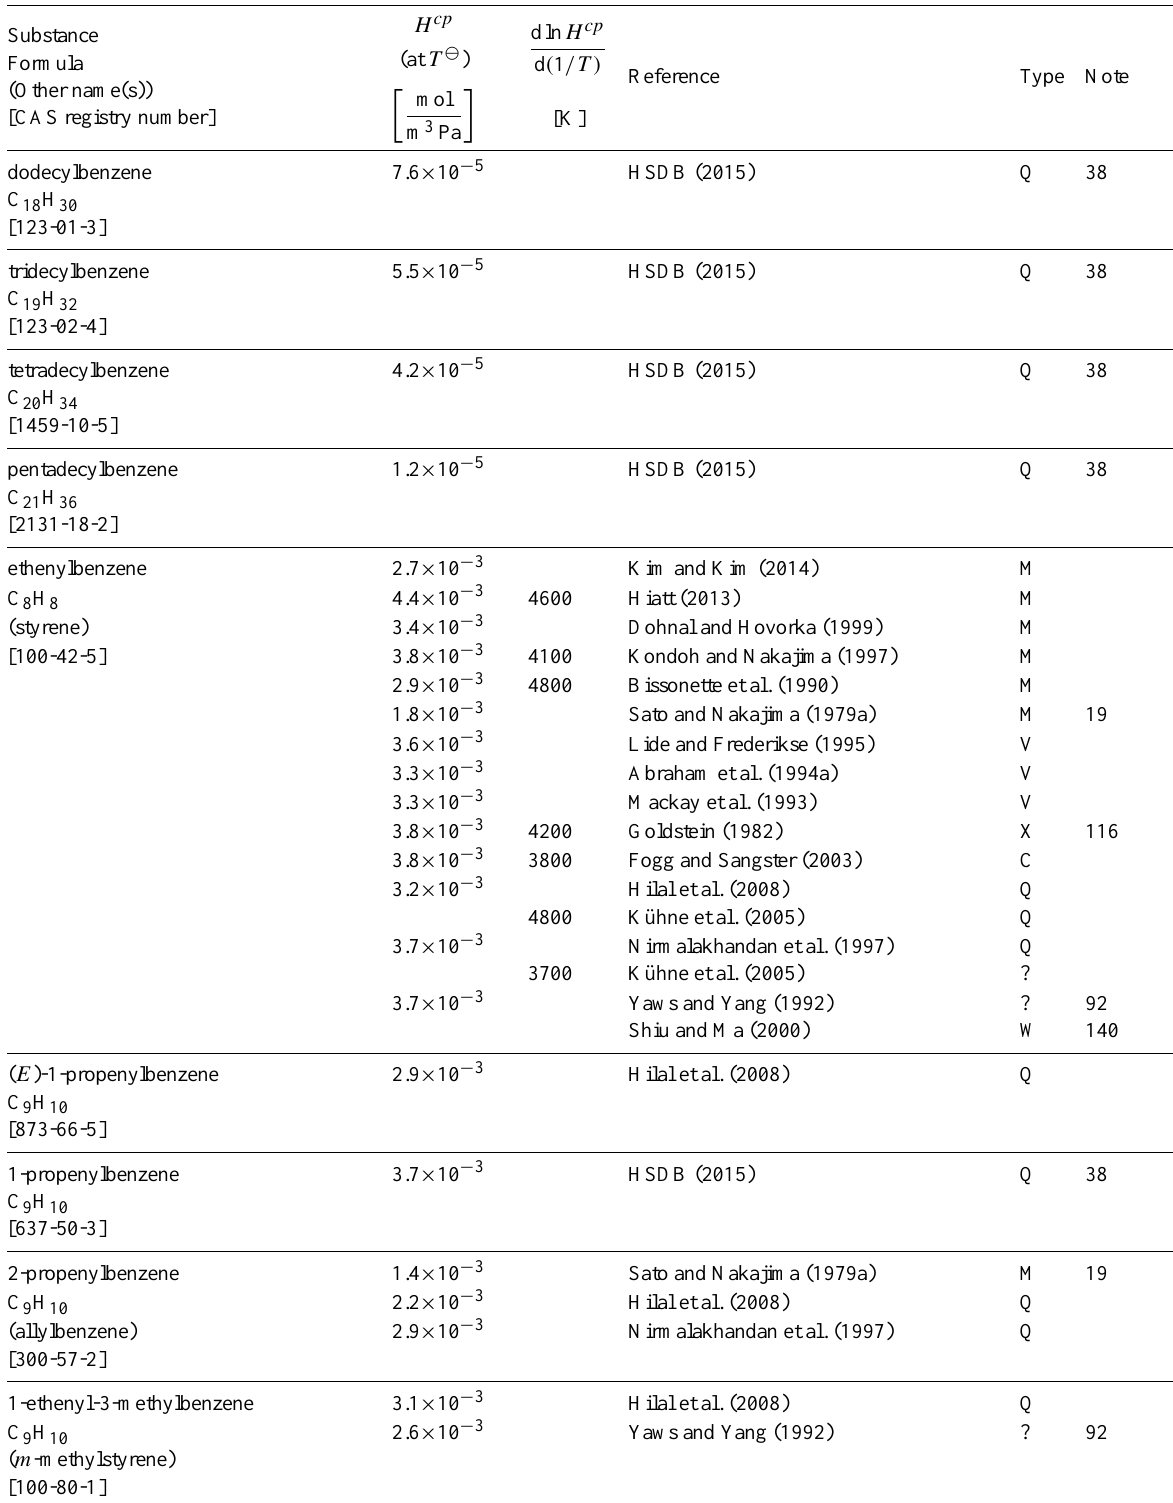
Table 6: Henry’s law constants for water as solvent